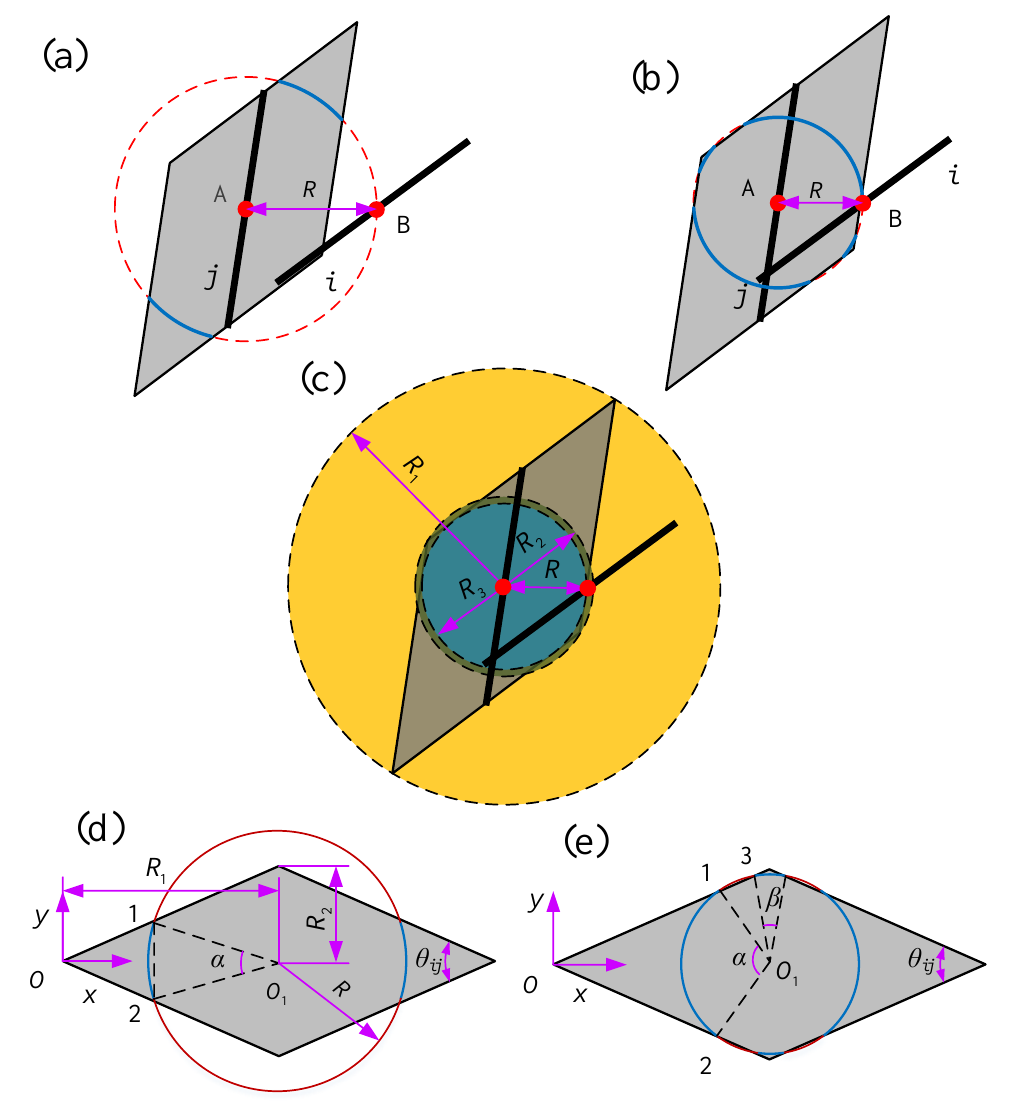
Figure A1. A schematic diagram for the intersecting probability of two arbitrary fibers. ( a ) Four arcs cut by the rhombus edges, ( b ) eight arcs cut by the rhombus edges, ( c ) range partition of four cases of the intersecting probability, and Cartesian coordinate systems of the cases of ( d ) the four arcs and ( e ) the eight arcs.